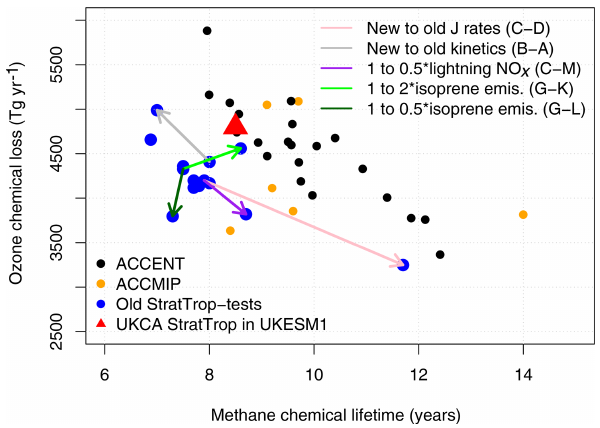
Figure 4. Comparison of early tests of the StratTrop scheme run- ning in an older version of UKCA (blue dots) with the scheme applied in UKESM1 (red triangle; free-running simulation), other CCMs which took part in the ACCMIP intercomparison (orange dots) and CTMs which took part in the ACCENT intercomparison (black dots). The letters in the legend (i.e. B–A) refer to the experi- ments outlined in Table